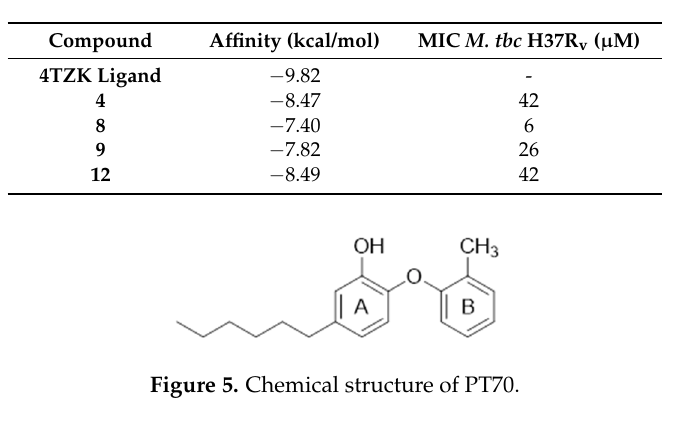
Table 5. Results of affinity calculations by Glide Scoring function in relation with in vitro activity against M. tuberculosis H37R v . against M. tuberculosis H37R v .